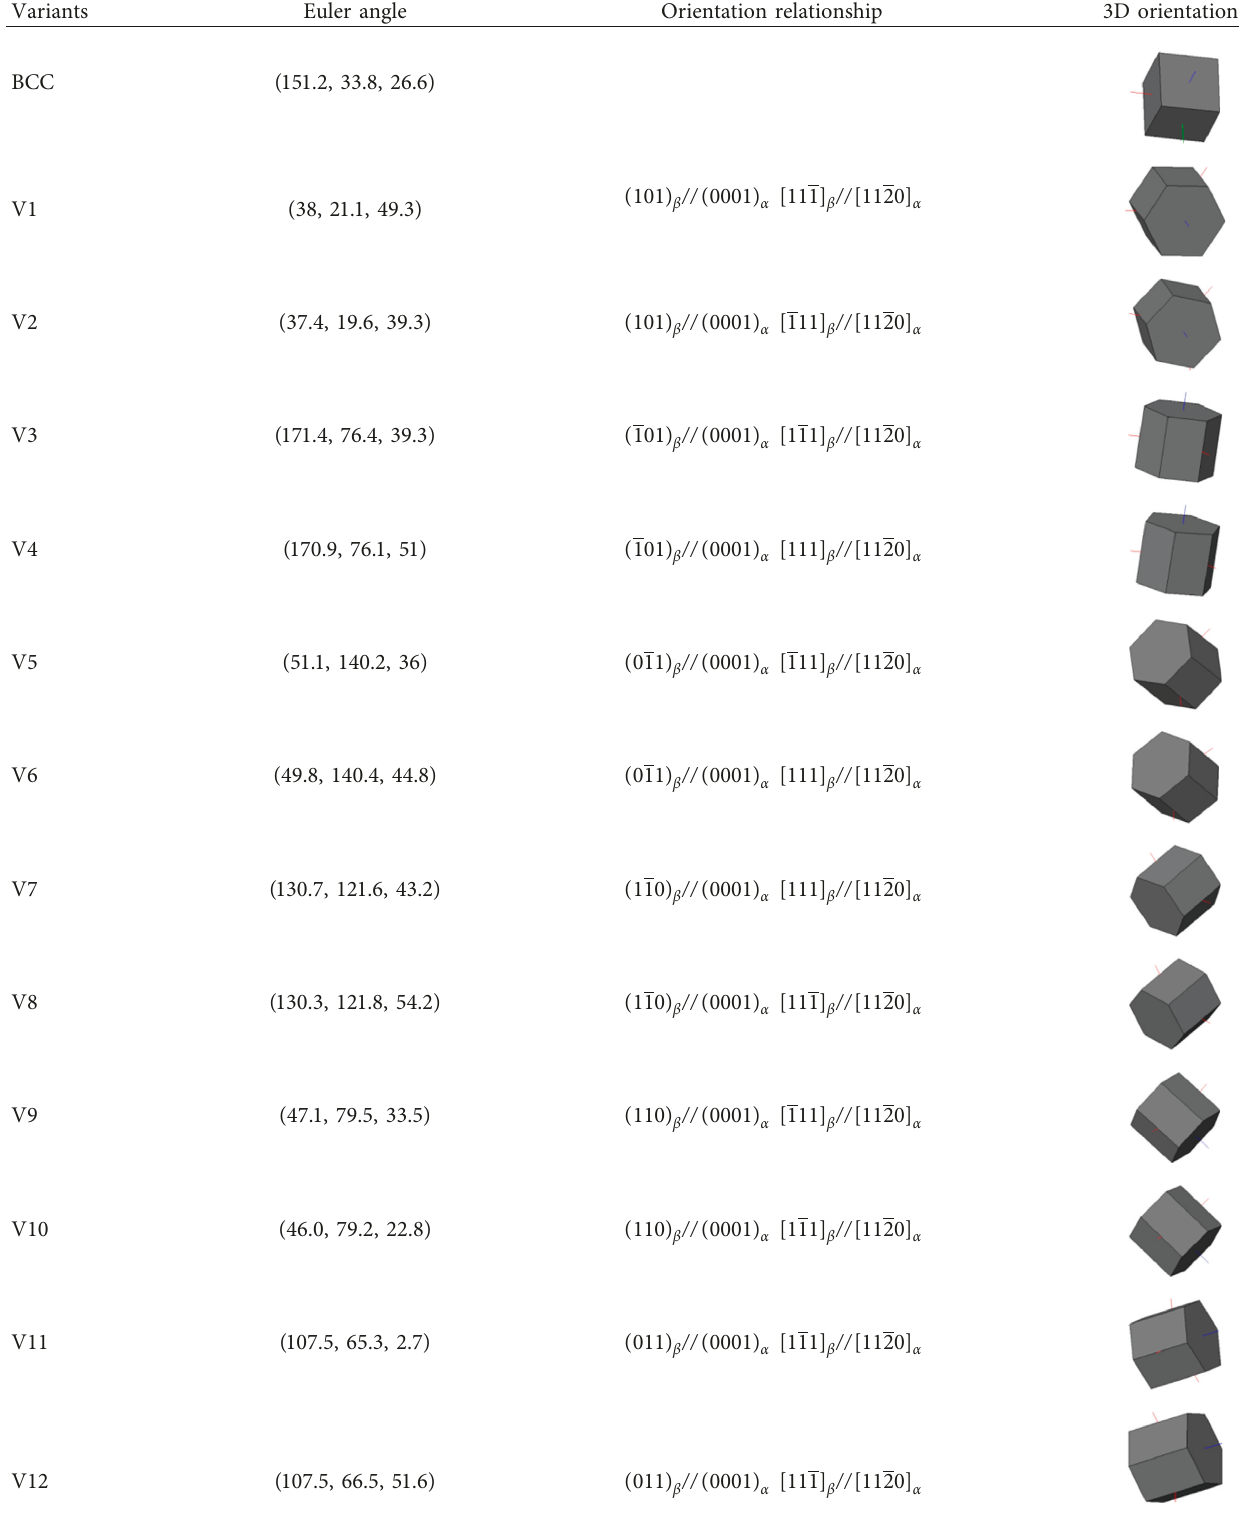
Table 1: Euler angles and Burgers orientation relationship of all 12